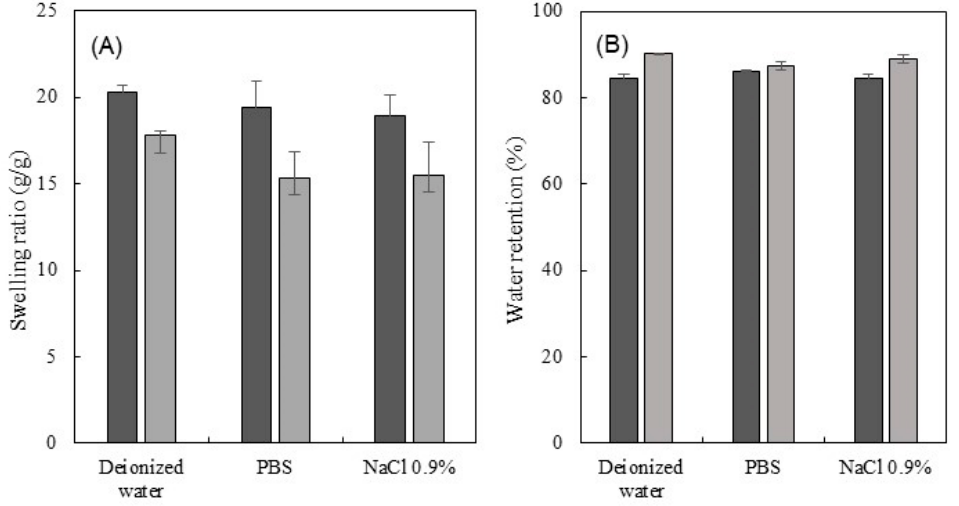
Figure 6. Swelling ratio ( A ) after 10 min and water retention capacity ( B ) after 30 min incubation of the Na5 1 * 4 (dark grey) and the Na5 1 * 6 (light grey) hydrogels, in deionized water, PBS, and NaCl 0.9%, at 37 °C.